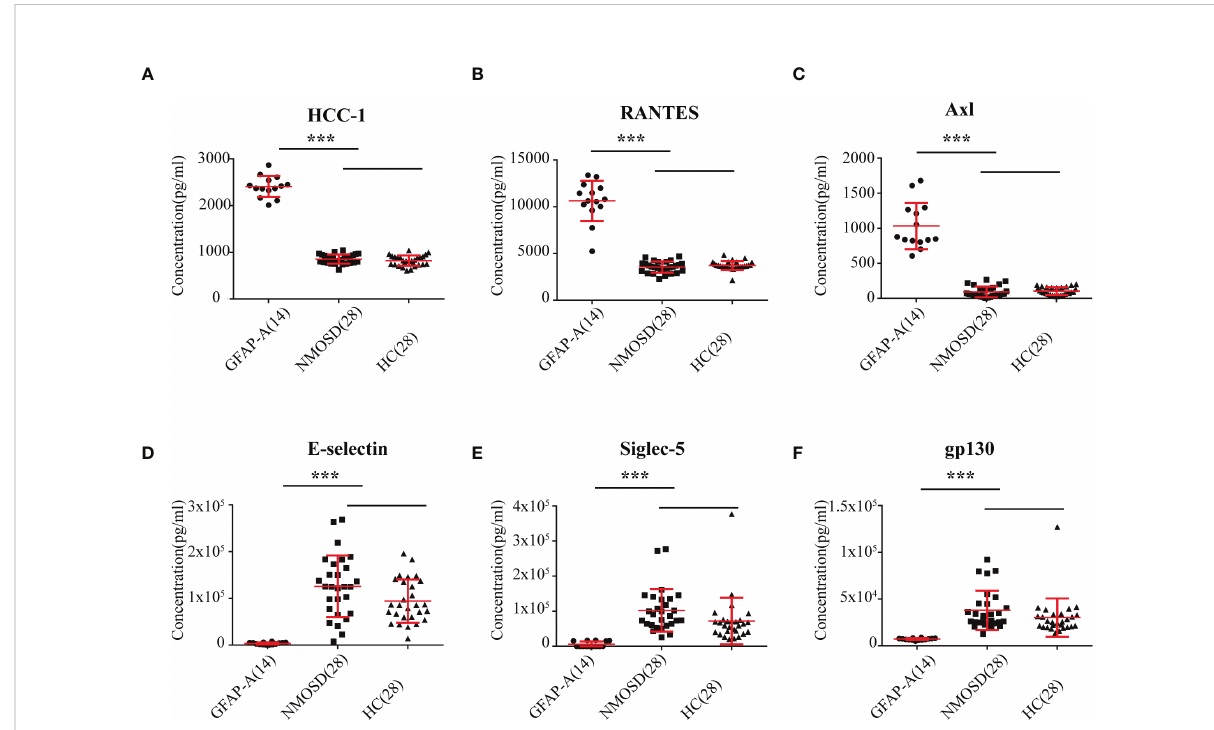
FIGURE 4 Scatter plot of the top 6 DEPs unique to GFAP-A. Serological concentrations (pg/ml) of the top 3 upregulated proteins (HCC-1, RANTES and Axl) that unique to GFAP were scatter plotted in (A – C) . Serological concentrations (pg/ml) of the top 3 downregulated proteins (E-selectin, Siglec-5 and gp130) that unique to GFAP-A patients were scatter plotted in (D – F) . The results are the means ± SEM. The non-parametric test was used for statistical analyses, and a p value of 0.05 or less was considered signi fi cant. *** p <